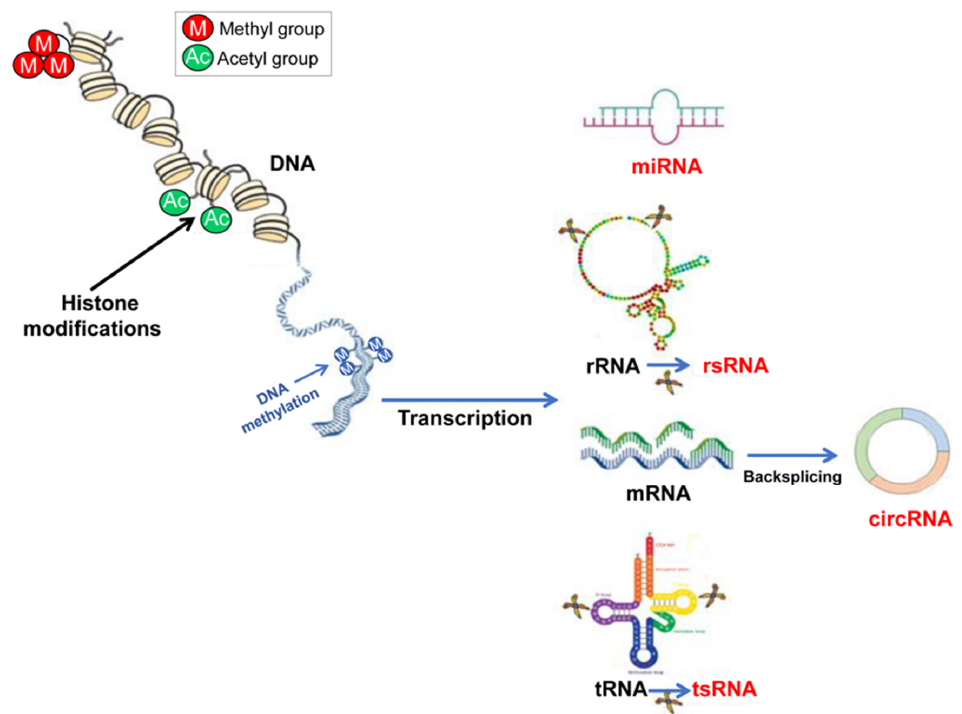
Figure 1. A schematic view of the main epigenetic processes. Gene expression can be epigenetically regulated at the transcriptional level, via DNA methylation and/or through histone histone PTMs able to conduct chromatin remodeling. The epigenetic regulation at the translational level is mainly under the control of ncRNAs. In sperm cells, recent results point to some classes of ncRNAs as mainly involved in their physiology, miRNAs, rsRNAs, tsRNAs and circRNAs, the last cited produced by mRNAs through a backsplicing reaction.